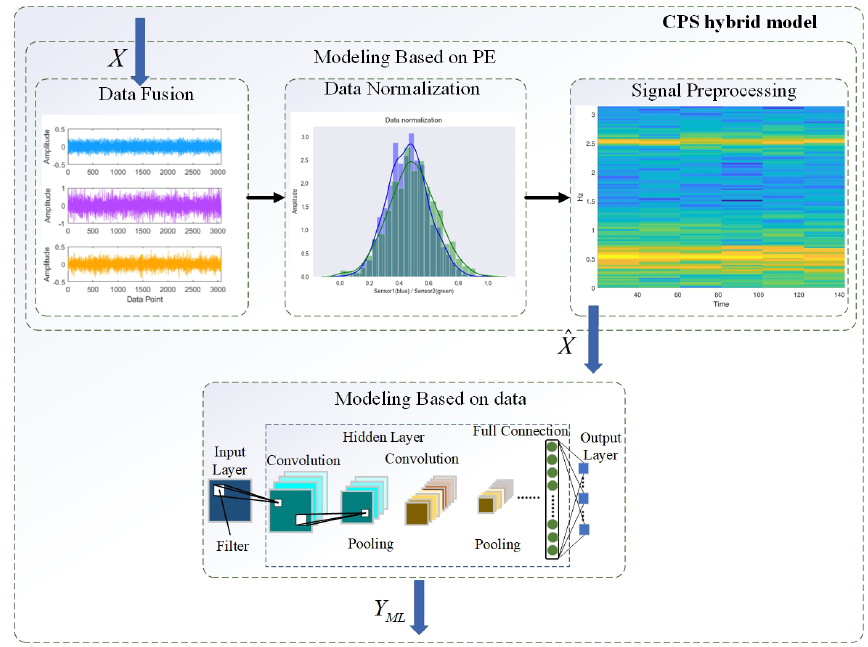
Figure 2. A detailed flow chart of CPS hybrid